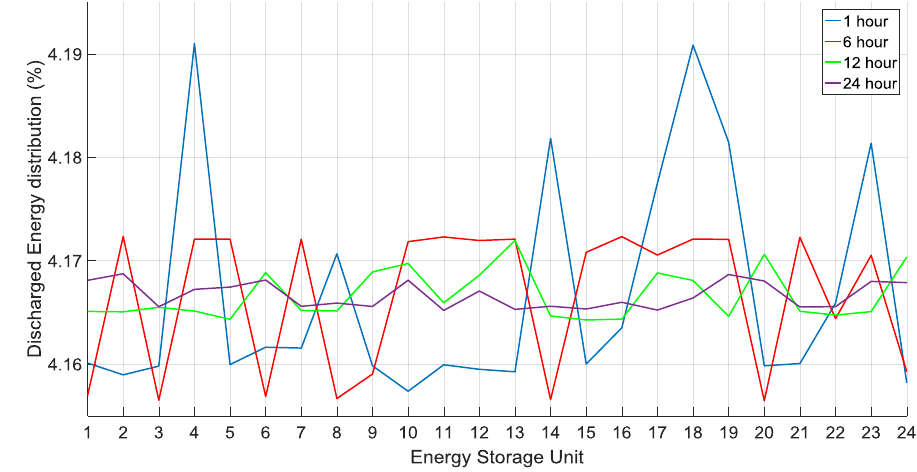
Figure 13. Discharged energy distribution of ESUs according to operation time.